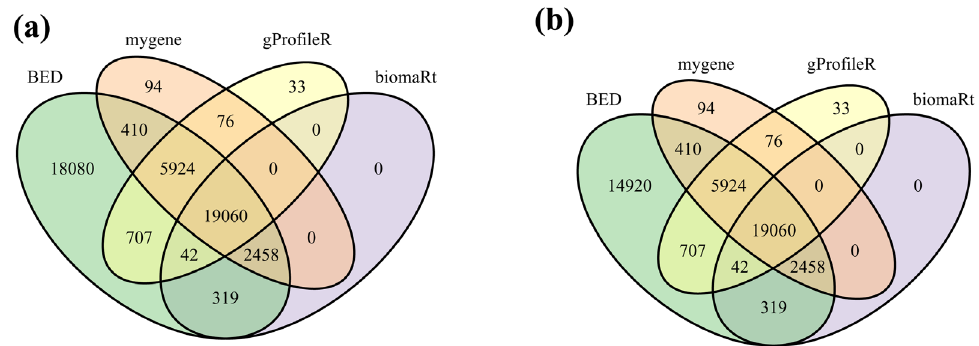
Figure 4. Venn diagrams showing the number of human Ensembl gene identifiers mapped to at least one human Entrez gene identifier by the different tested tools when focusing ( a ) on all 69,056 or ( b ) on current 65,256 BEID (Ensembl 92